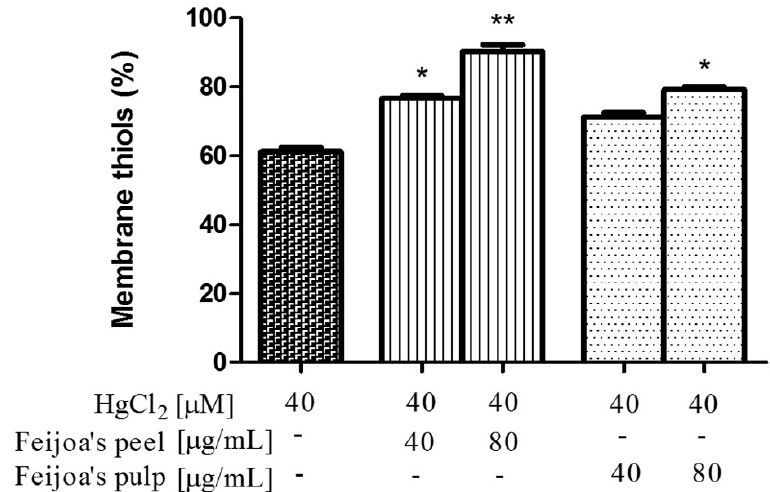
Figure 6. Feijoa peel and pulp extracts protect against Hg-induced membrane thiol depletion in RBC. Cells were treated with 40 µM HgCl 2 for 4 h in the presence of increasing concentrations of Feijoa peel or pulp. Data are the means ± SEM ( n = 9). Statistical significance was calculated with one-way ANOVA followed by Tukey’s test. * ( p < 0.05) and ** ( p < 0.01) indicate significant differences from cells lacking Feijoa extract treatment.